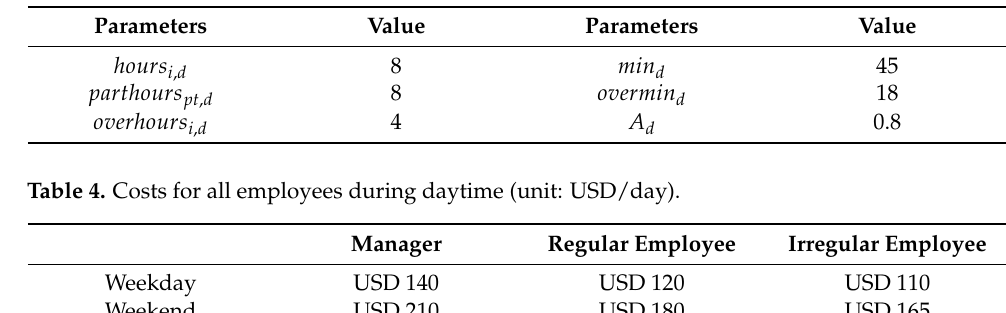
Table 3. System parameters.